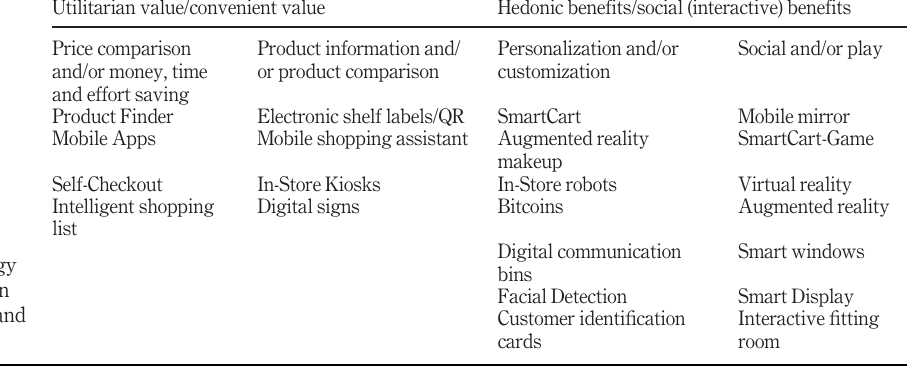
Utilitarian value/convenient value Price comparison and/or money,